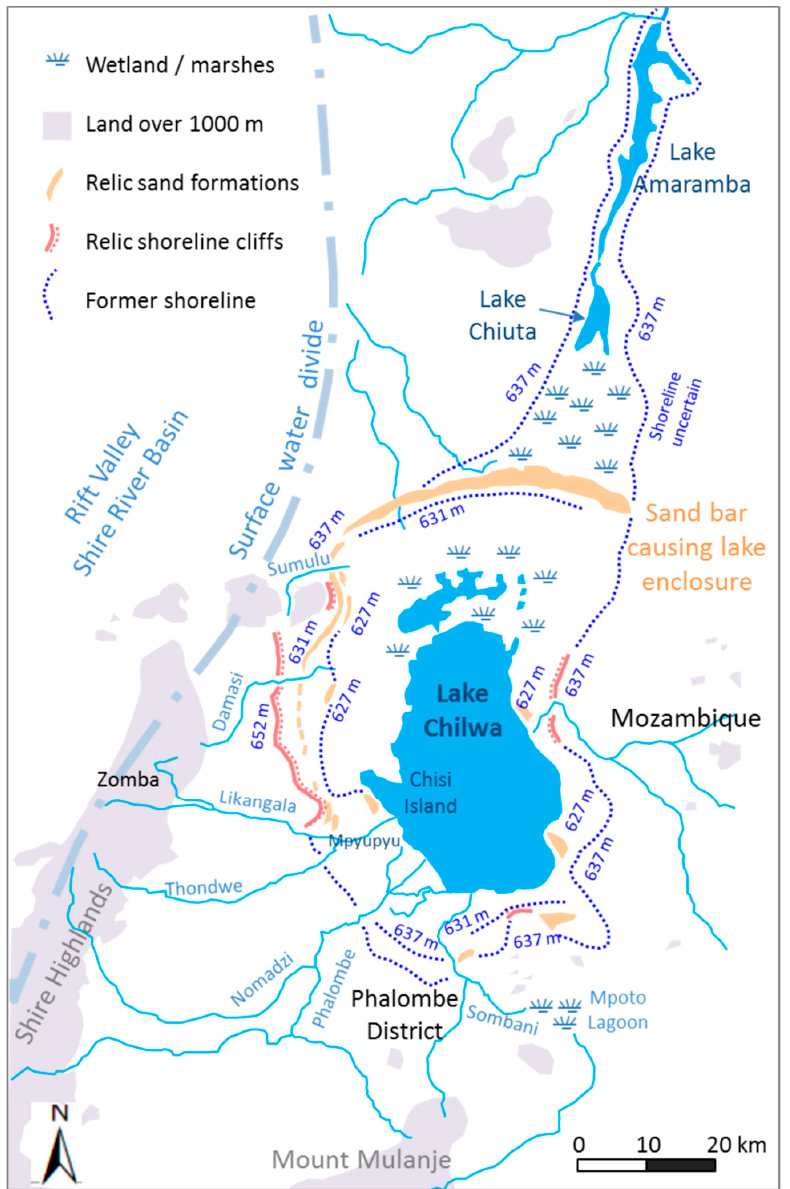
Figure 1. Lake Chilwa basin map showing water features and former (relict) lake shorelines (collated from literature cited in Section 3.1). Small-scale water features such as stream networks and dambo wetland are not shown.